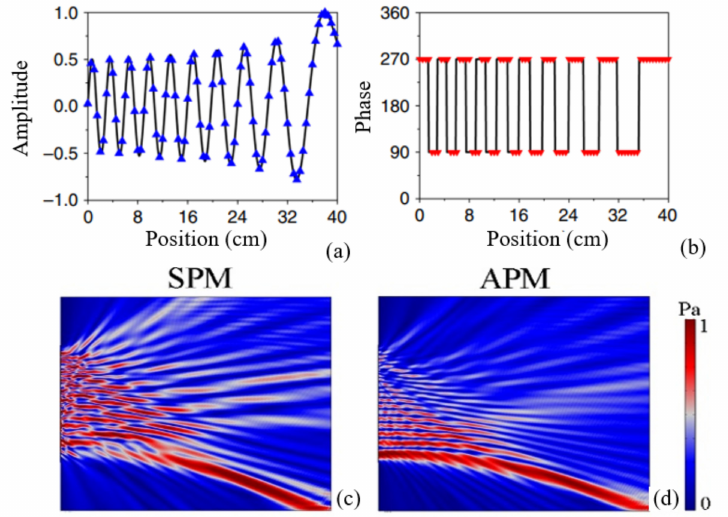
Figure 7. ( a ) Amplitude distribution along metasurface; ( b ) Phase distribution along metasurface; ( c ) Airy beam based on SPM; ( d ) Airy beam based on